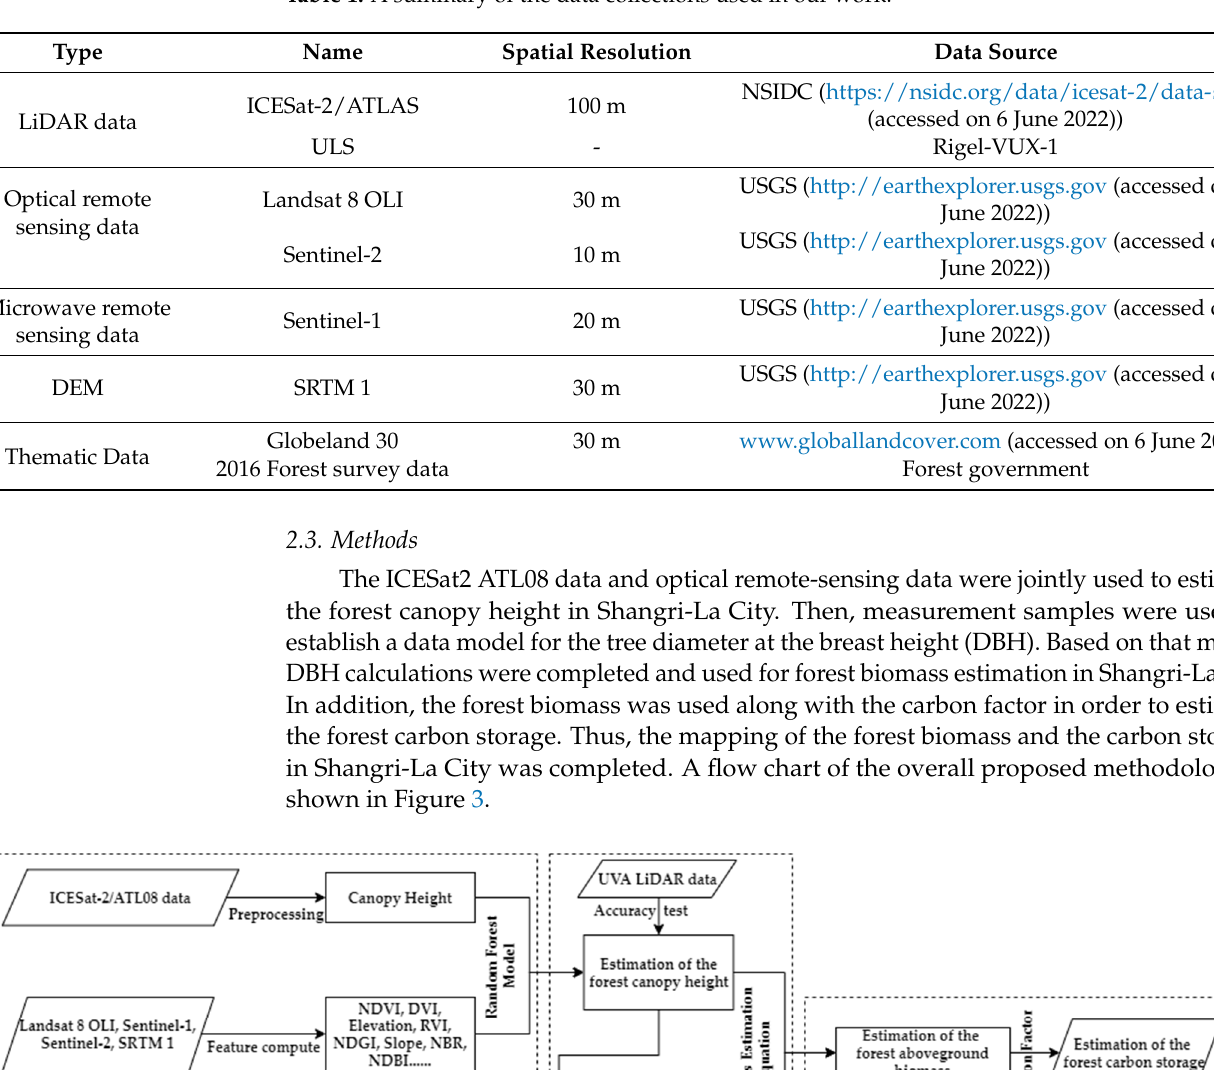
Table 1. A summary of the data collections used in our work.